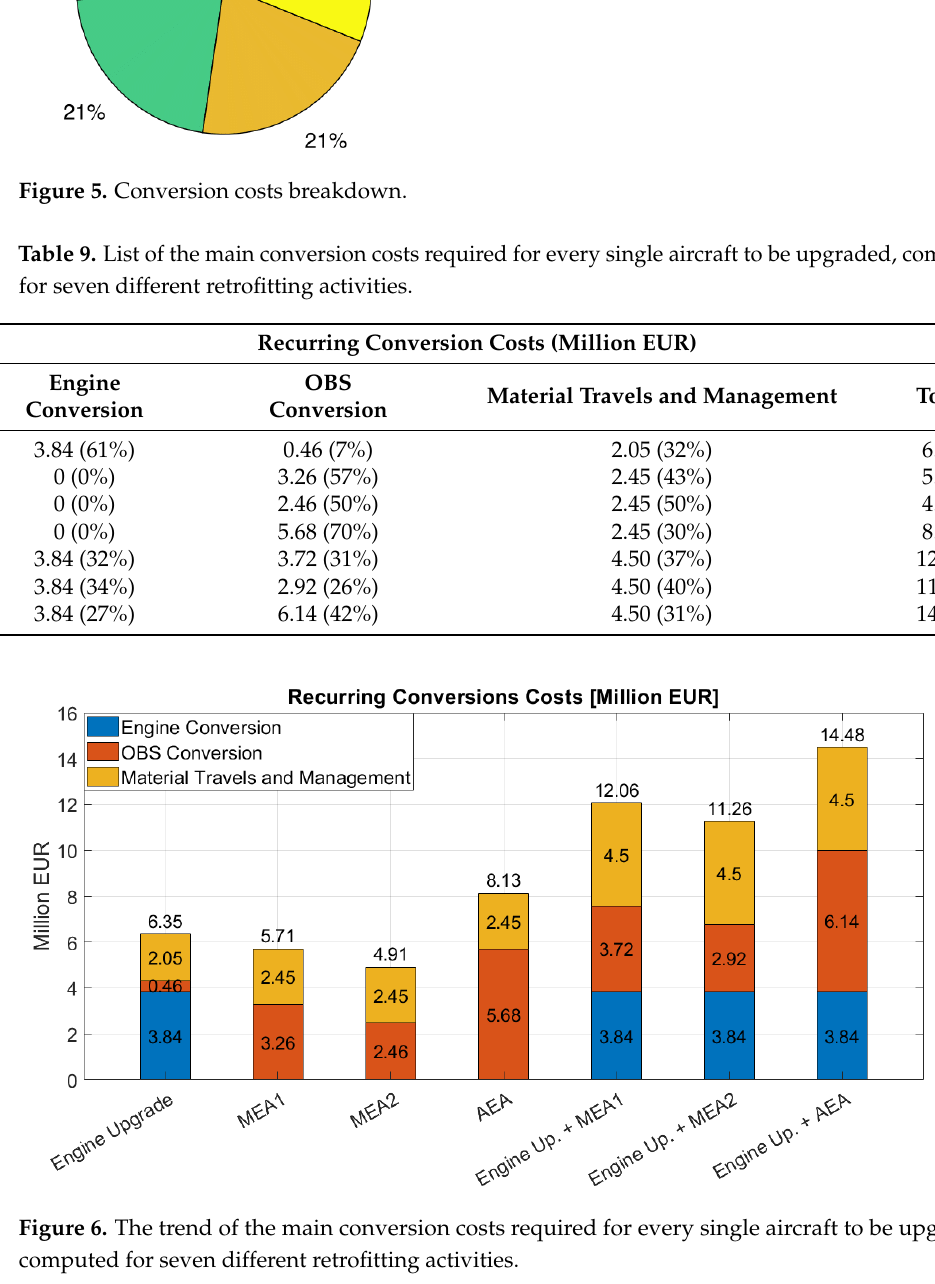
Table 9. List of the main conversion costs required for every single aircraft to be upgraded, computed for seven different retrofitting activities.